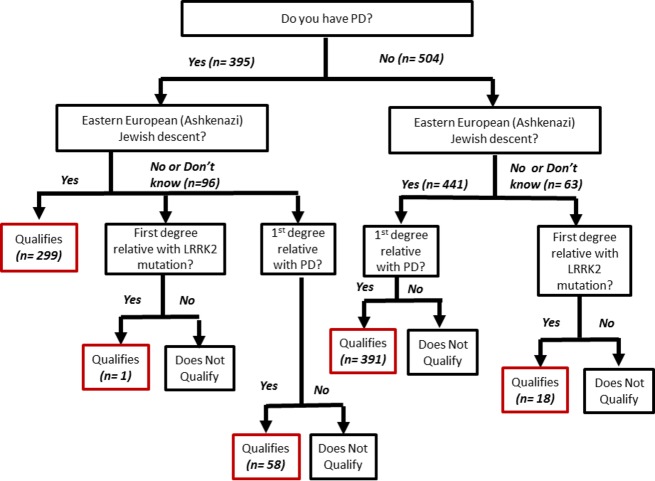
Screening algorithm.